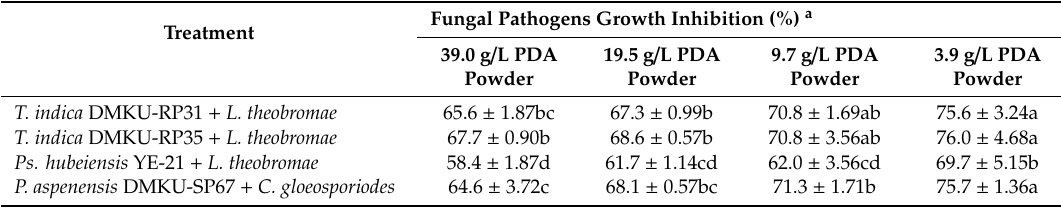
Table 1. Inhibition of L. theobromae and C. gloeosporiodes by the antagonistic yeast strains on PDA with di ff erent nutrient concentrations at 25 ◦ C for 3 and 14 days, respectively.